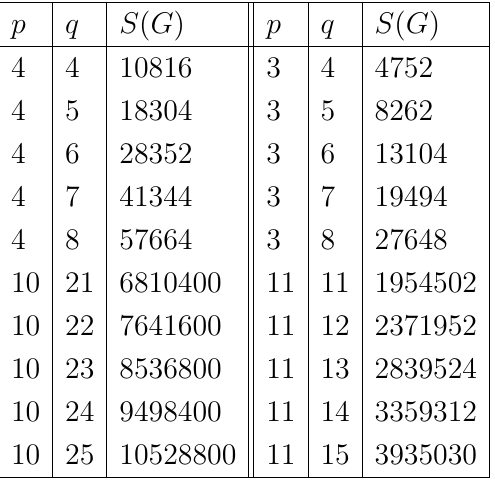
Table 2. Schultz index of long tubes, p ≤ q